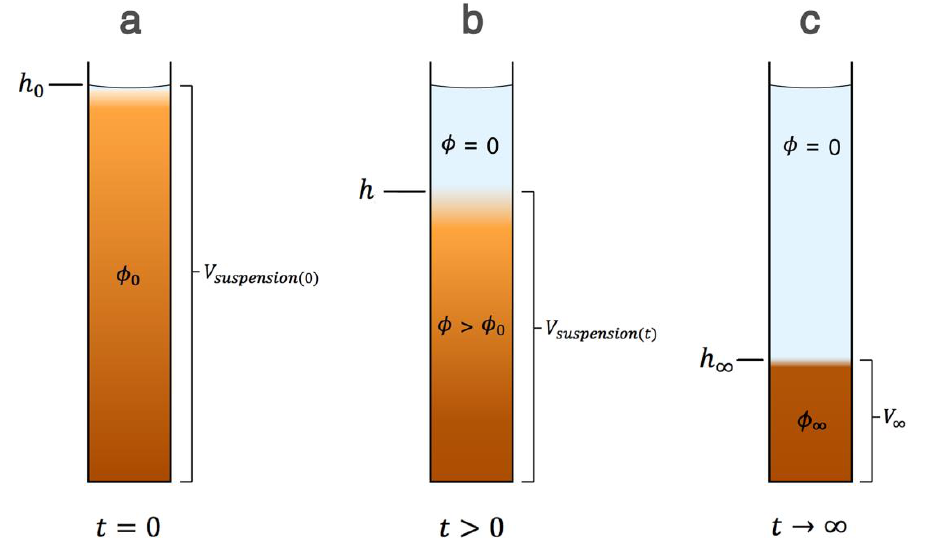
Figure 2. Schematic diagram illustrating the settling of a flocculent bacteriogenic iron oxides (BIOS) suspension in an experimental batch column. Before settling at t = 0, the homogenous suspension is characterized by a uniform initial solids volume fraction φ 0 and a volume V suspension ( 0 ) equivalent to the total aqueous volume in the container ( a ). At times t > 0, the aggregates settle toward the base of the container with a progressively decreasing suspension–water interface ( h < h 0 ) , forming a separate suspension phase of aggregates at the base of the container with volume V suspension ( t ) < V suspension ( 0 ) below a clear liquor (in blue) where φ = 0 ( b ). As t → ∞ , the suspension settles to a final equilibrium height h ∞ and equilibrium suspension volume V ∞ ( c ), based on inverse modelling estimates.